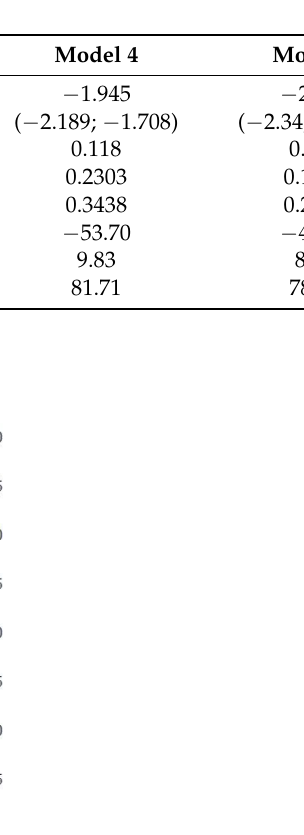
Figure 5. Maps of the observed (UW: unweighted and HT: Horvitz–Thompson) and spatial estimated prevalences of fever (UB: Unadjusted Binomial estimator (Model 1), LN: Logit-normal estimator (Model 2), AN: Arcsine-square root transformation estimator (Model 3), PL: Pseudo-likelihood estimator (Model 4), ES: Effective Sample size estimator (Model 5), and ES-deff: Effective Sample size estimator using design effect (Model 6)) by the province in Mozambique using IMASIDA 2015.